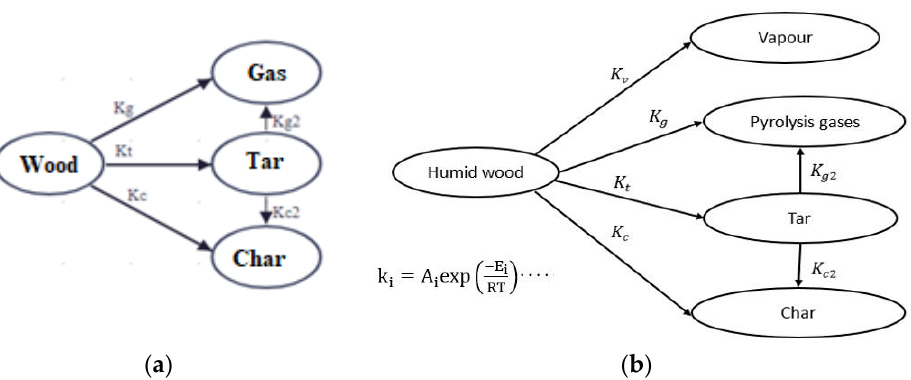
Figure 2. Thermo-chemical transformations of Di-Blasi and Russo model ( a ) without influence of moisture content, and ( b ) with influence of moisture content.